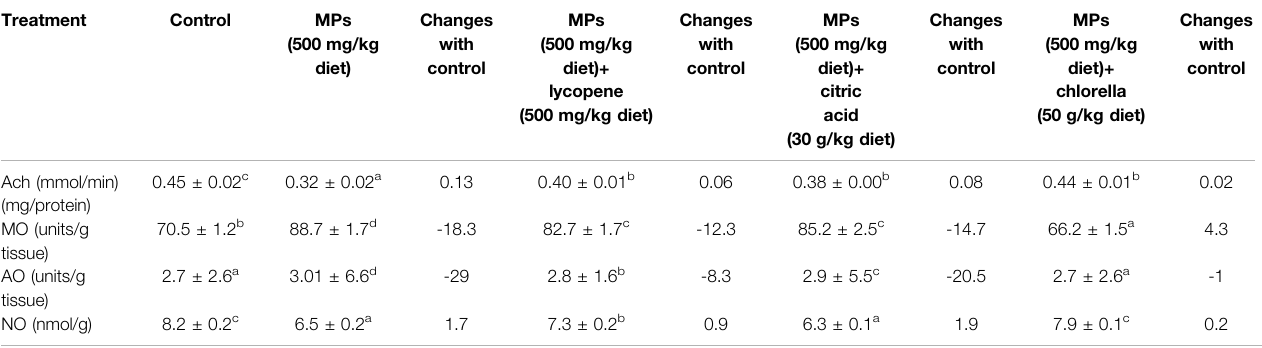
TABLE 1 | Effect of microplastic on neurotoxiclogical biomarkers as mean ± SE and changes with control in African cat fi sh ( Clarias gariepinus ) exposed to MPs (500 mg/kg diet), MPs (500 mg/kg diet)+ lycopene (500 mg/kg diet), MPs (500 mg/kg diet)+ citric acid(30 g/kg diet) and MPs (500 mg/kg diet)+ chlorella (50 g/kg diet) for 15 days.